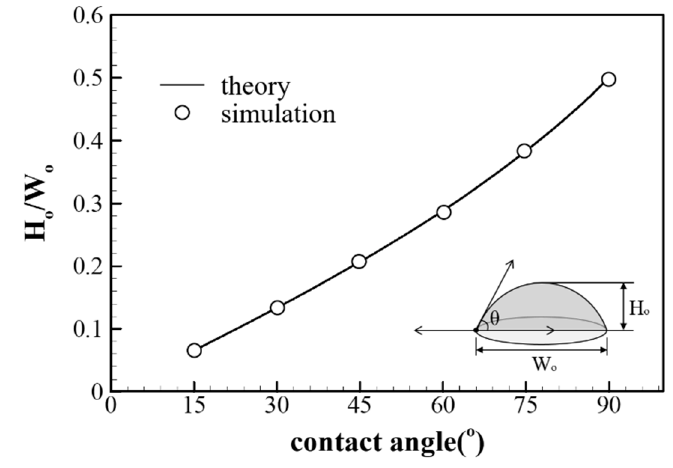
Figure 2. Comparison between the simulation results and theoretical curve plotted using the geometric aspect ratio of the liquid drop.